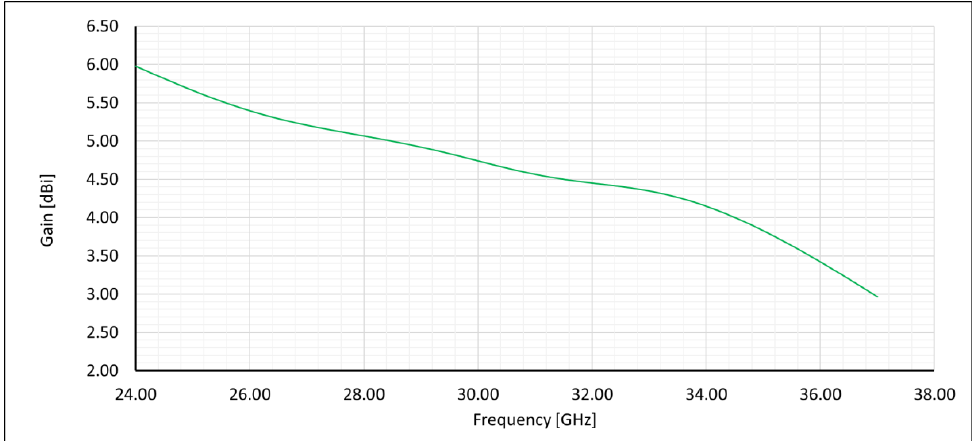
Figure 8. The chart of antenna gain as a function of frequency for the proposed antenna working in the 5G system.